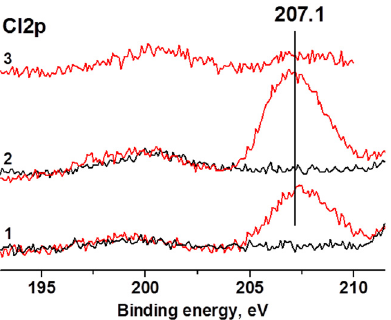
Figure 4. The Cl2p XPS spectra of CNTs (1), N-CNTs (2), and PV 2 W 10 /N-CNTs (3): initial carbon materials-black curves, treated by HClO 4 (0.15 M in CH 3 CN)-red curves). Reprinted from Catalysis Today, Vol. 354, Evtushok et al., H 2 O 2 -based selective oxidations by divanadium-substituted poly- oxotungstate supported on nitrogen-doped carbon nanomaterials, 196–203, Copyright 2020, with permission from Elsevier.